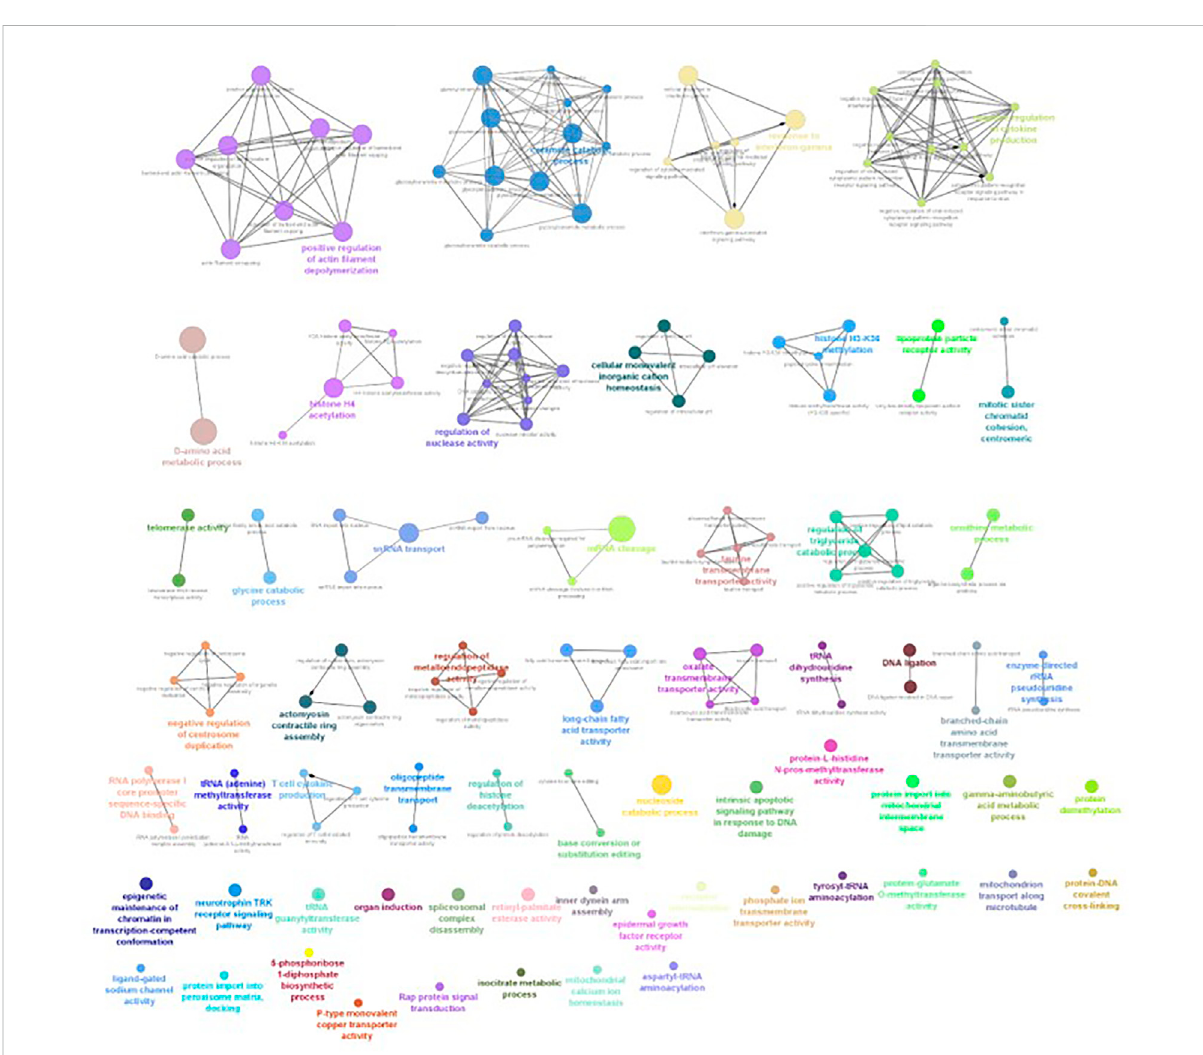
FIGURE 7 ClueGO enrichment network of the 4-ppt salinity-challenged treatment group DEGs of L. rohita , with a p -value cut-off < 0.05, the interactions of the GO terms network determined by functional nodes, and edges shared between differentially expressed genes with a kappa score of 0.4. The generated network has 227 nodes and 554 edges. Each node represents an individual biological process, and the color refers to the GO group. In total, 60 GO groups are present in the network, and edges represent the relationship between the GO terms based on the similarity of their associated genes. The bold font indicates an important GO term that de fi nes the name of the biological process of each